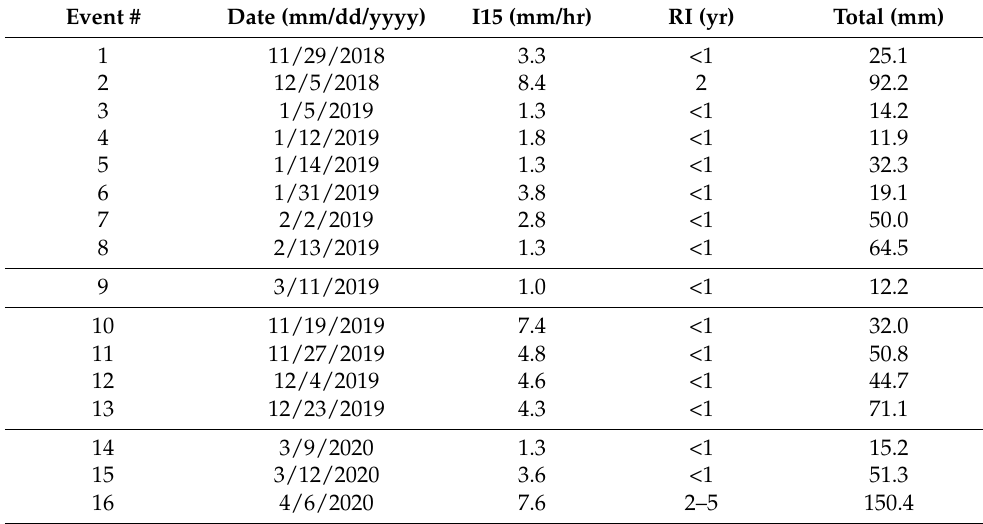
Table 2. Precipitation, maximum 15-min intensity (I15), recurrence interval, and total rainfall for significant events during the study period. Soil data were collected in between the dates above and below each horizontal